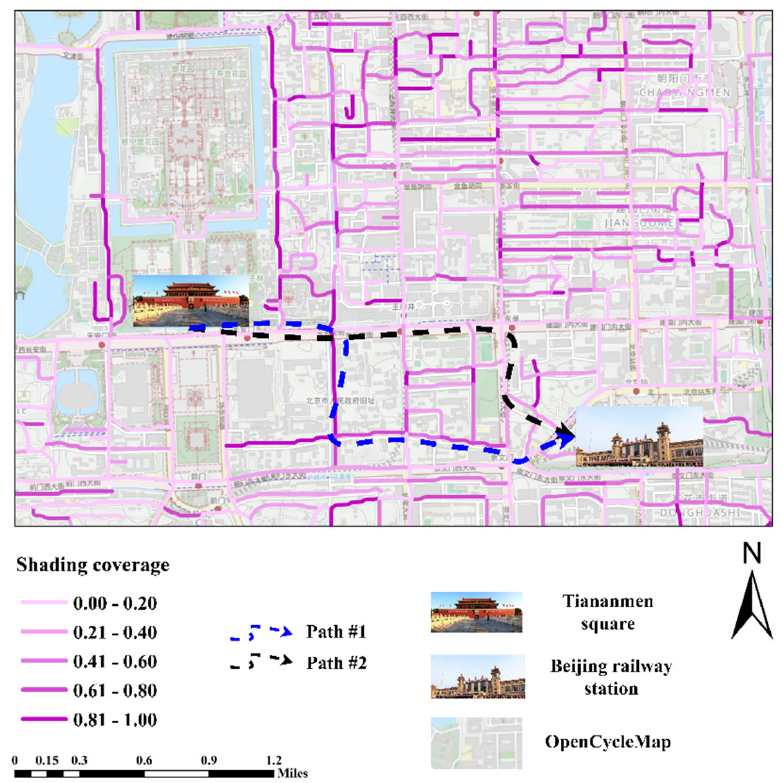
Figure 10. Comparison of shadow indices of different paths.